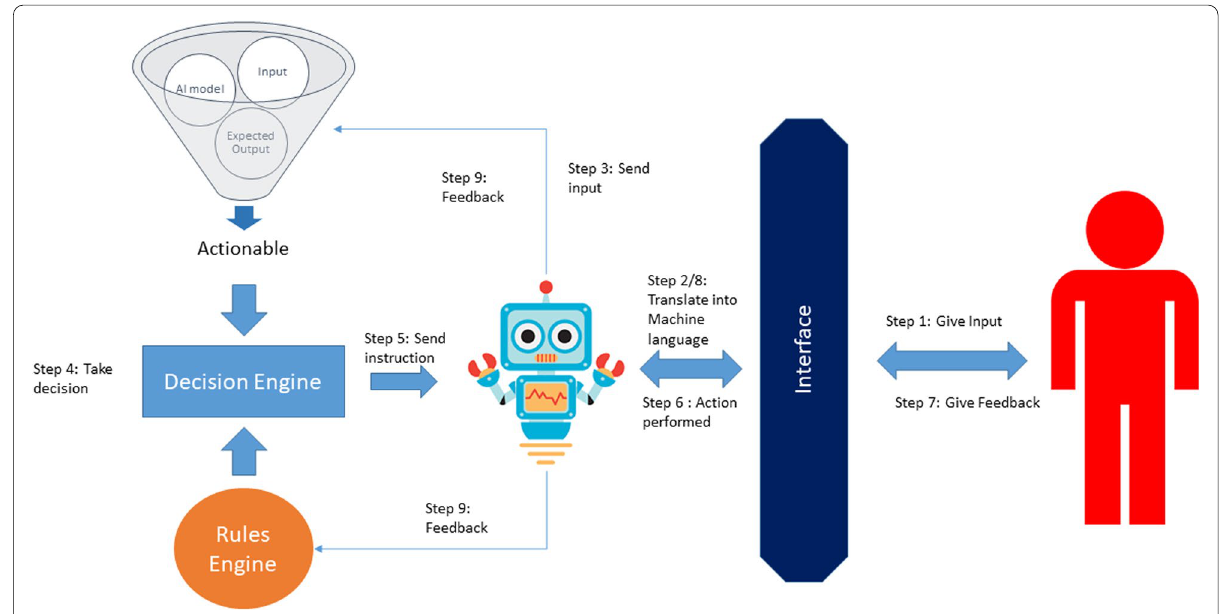
Fig. 1 Collaboration of Robotics and Artificial